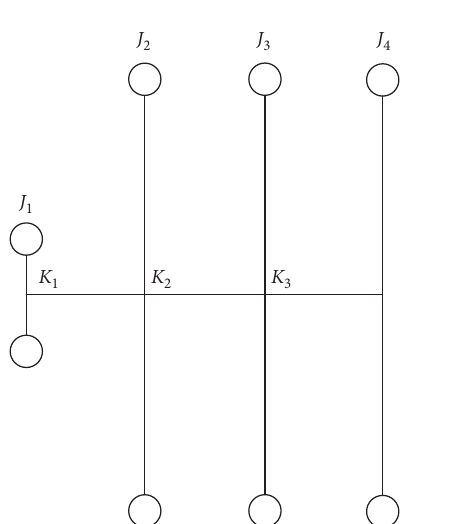
Figure 3: Torsional vibration model under idle